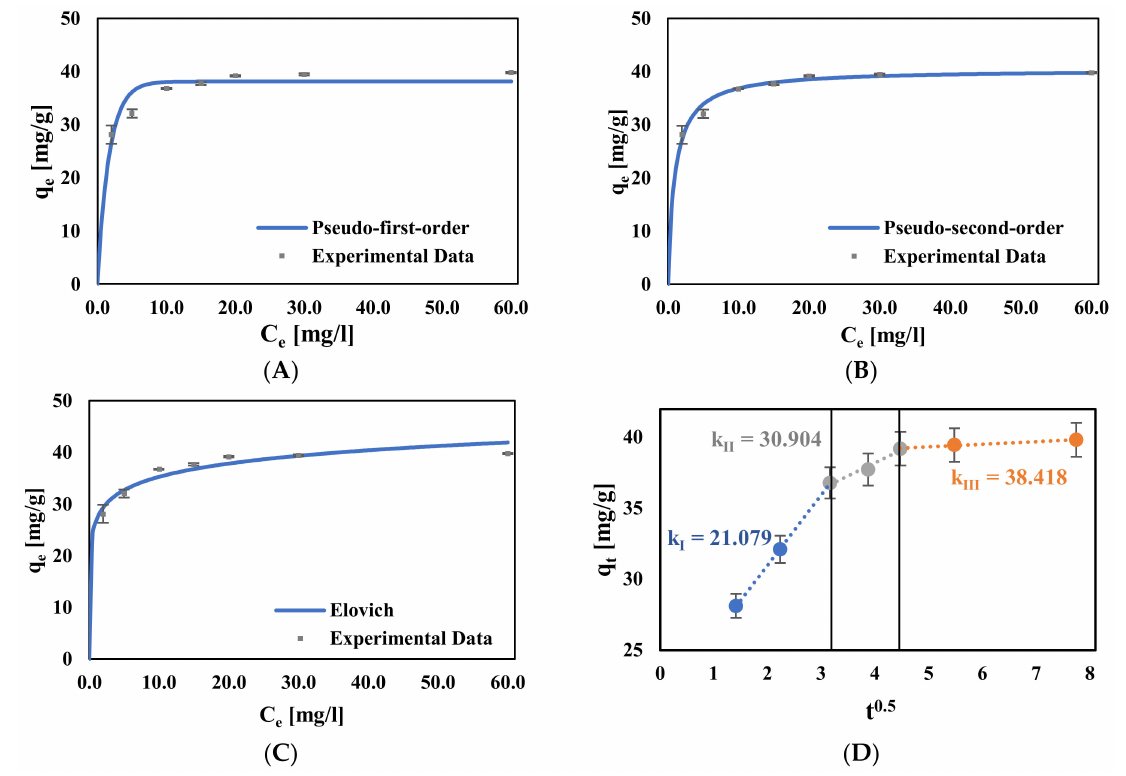
Figure 6. Kinetic nonlinear models: ( A ) pseudo-first-order; ( B ) pseudo-second-order; ( C ) Elovich; ( D ) linear model of intramolecular diffusion. Table 5. Parameters of the determined nonlinear kinetic